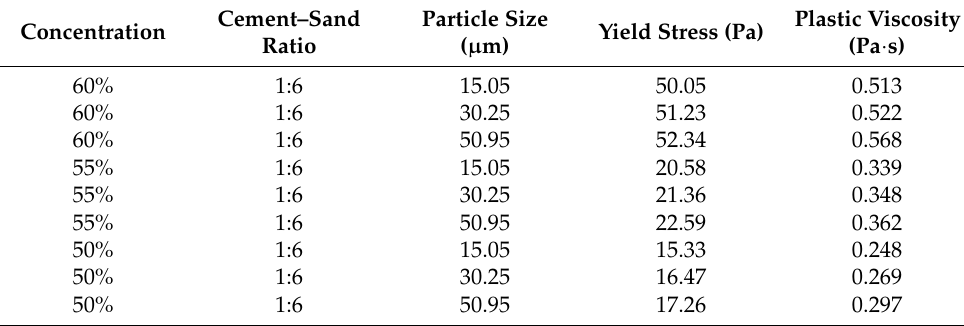
Table 6. Rheological characteristics of the